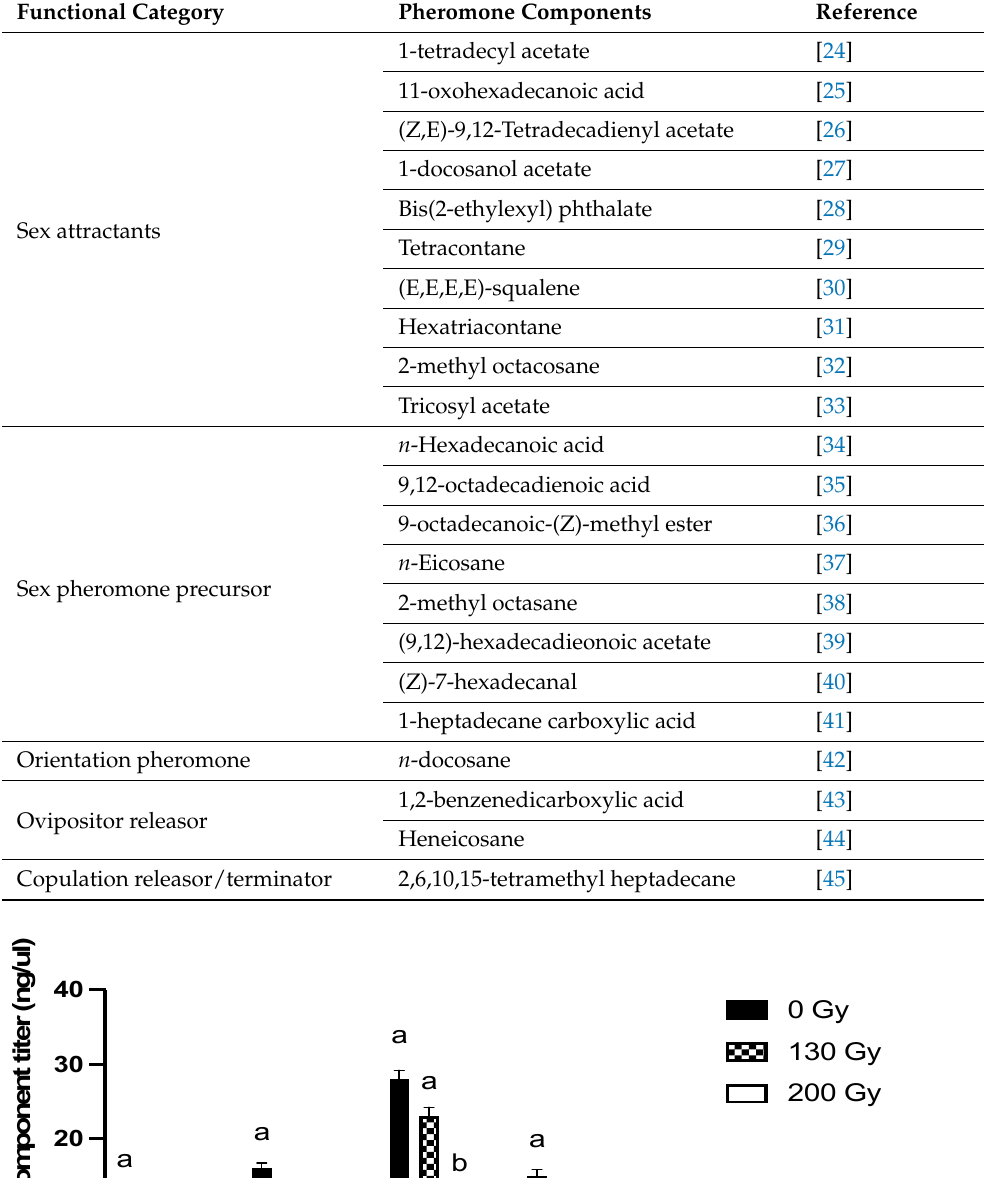
Table 2. Functional categorization of different pheromone components obtained from GC-MS analysis of pheromone gland extracts of female Spodoptera litura .